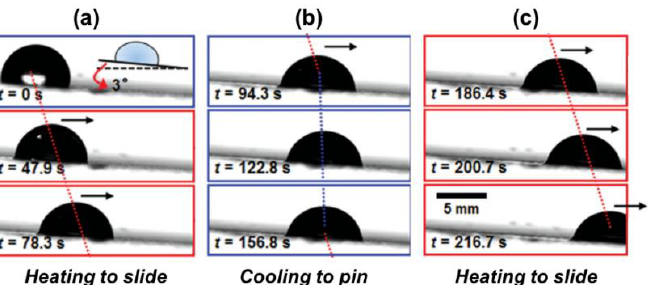
Figure 4. Demonstration of thermo-controllable drop sliding motion. ( a ) The LIS was heated to motivate the droplet sliding. ( b ) The droplet was pinned after removing the heat source. ( c ) The droplet continued to slide. Reprinted with permission from [58]. Copyright (2014) Wiley-VCH.